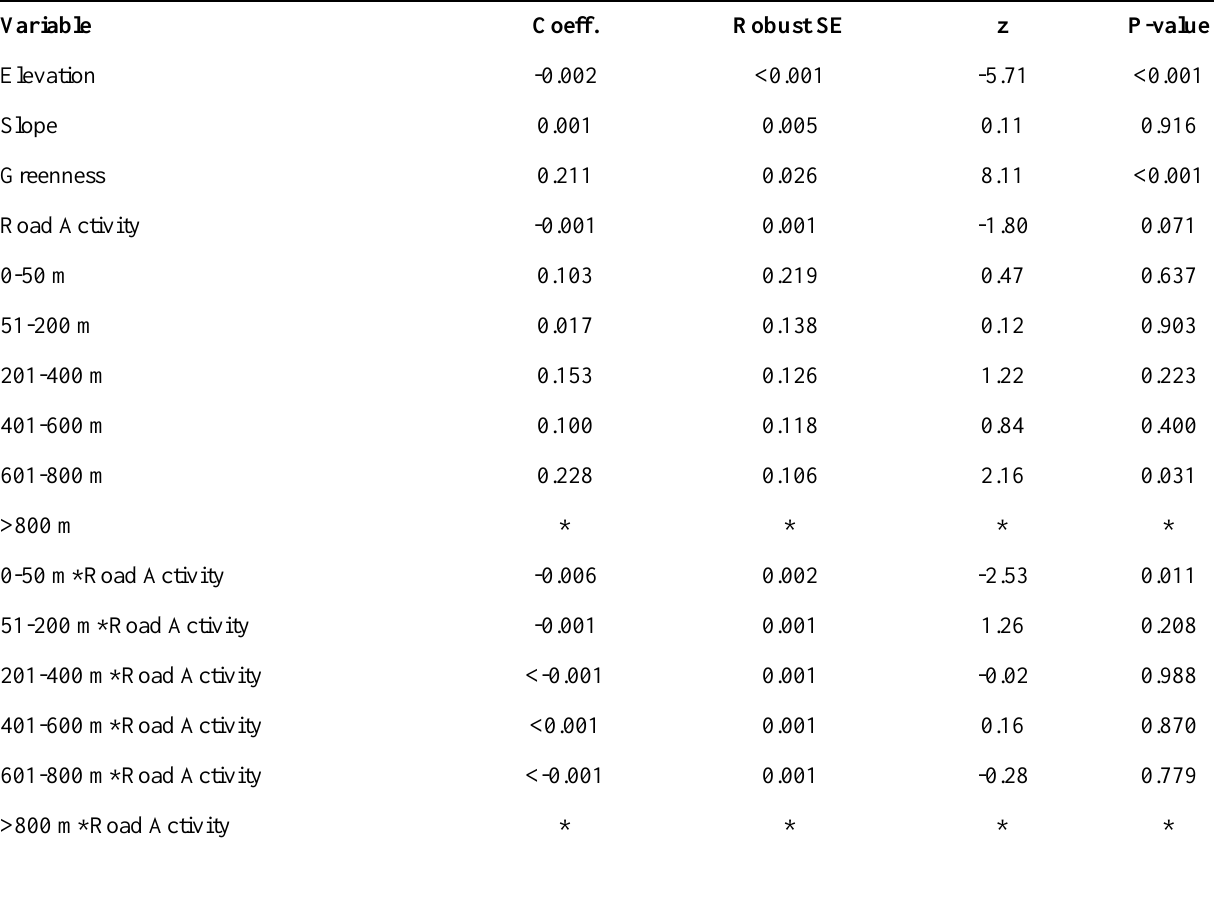
Table A1.4 . Model results for elk near roads. Results predict elk occurrence near roads using matched case-control logistic regression. Variable